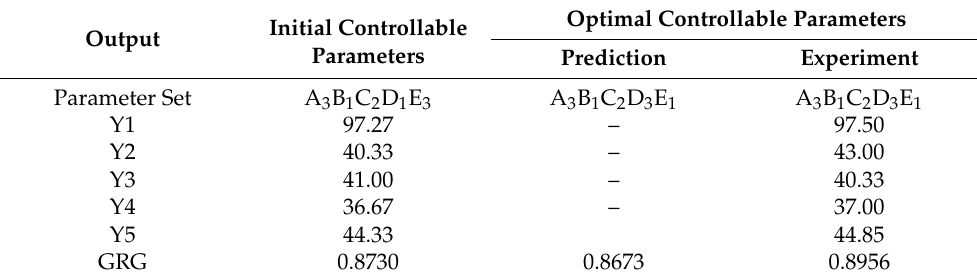
Table 10. Comparison of the optimization and experimental validation results during the flocculation of the Bacillus sp. BioSol021 cultivation broth and antimicrobial activity testing against the selected